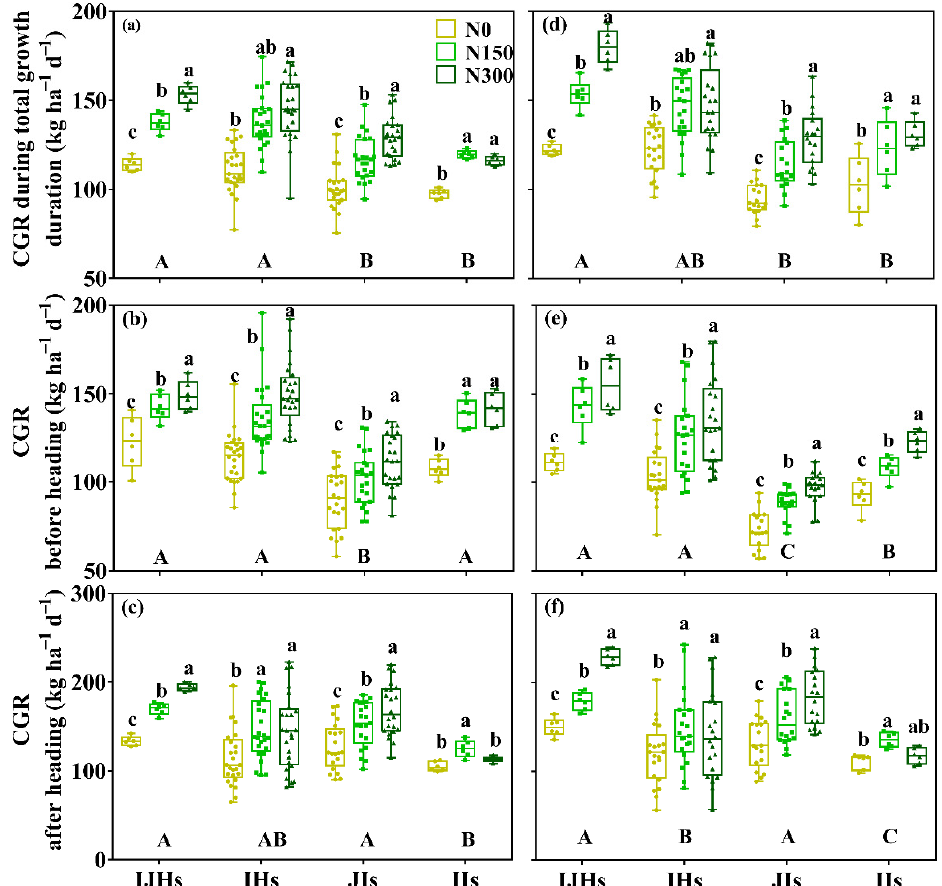
Figure 7. Boxplots of CGR during the total growth duration ( a , d ), CGR before heading ( b , e ), and CGR after heading ( c , f ) for indica-japonica hybrids (IJHs), indica hybrids (IHs), japonica inbreds (JIs), and indica inbreds (IIs) under different N levels in 2017 ( a – c ) and 2018 ( d – f ), respectively. Data are the means of three replicates. Different uppercase letters above the columns indicate statistical significance at the p < 0.05 level among different rice groups, and different lowercase letters above columns indicate statistical significance at the p < 0.05 level among different nitrogen levels.